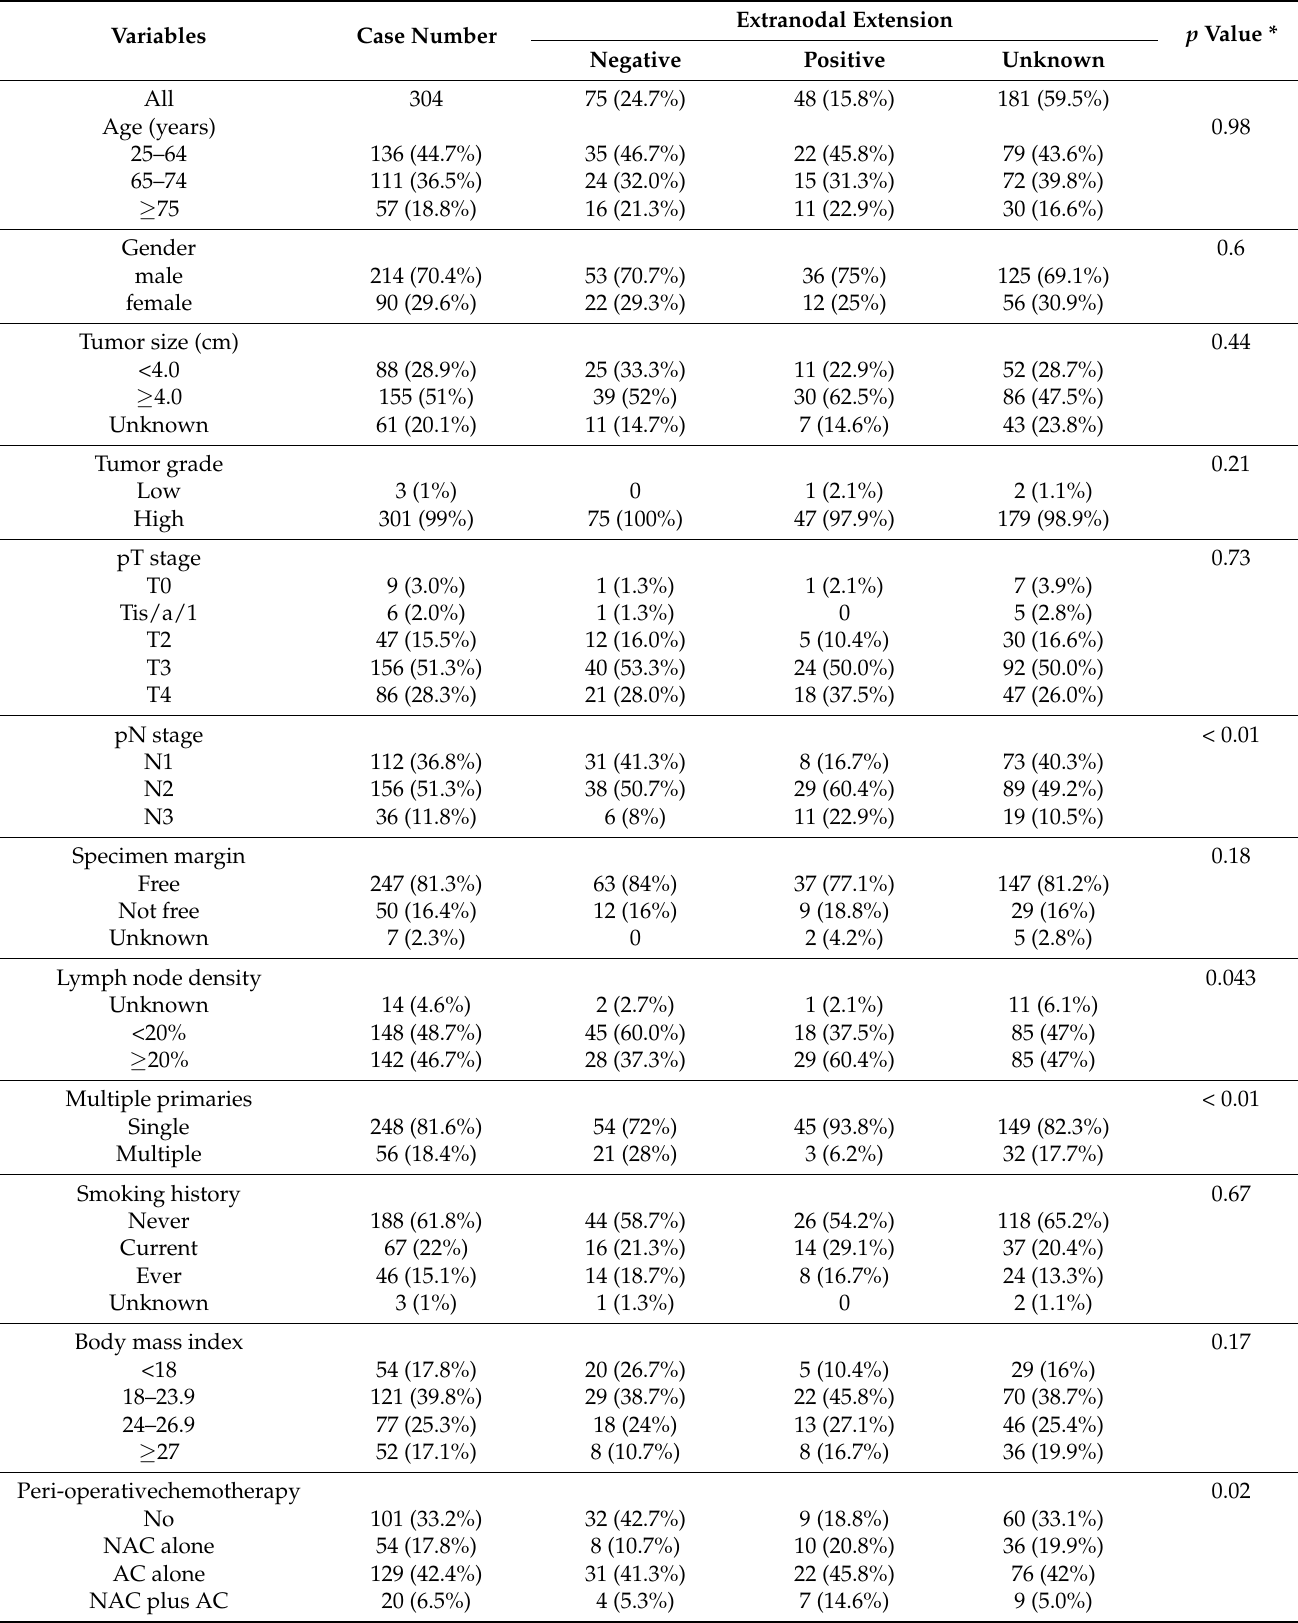
Table 1. Demographics of bladder cancer patients with lymph node involvement who received radical